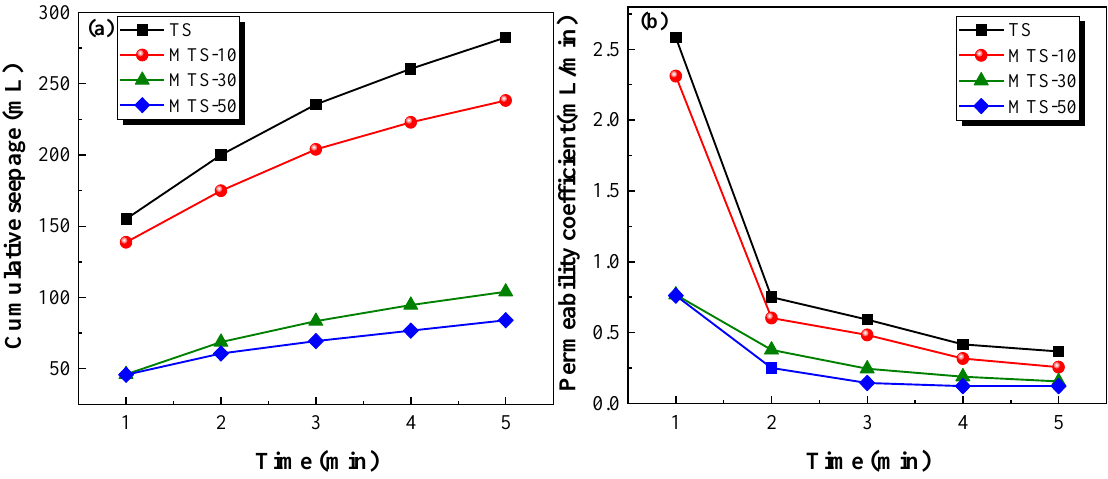
Figure 14. Cumulative seepage ( a ) and permeability coefficient ( b ) at different curing times. Figure 14 indicates that the cumulative seepage decreased with the increase in CACG content. Moreover, the cumulative seepage and the test time exhibited a positive